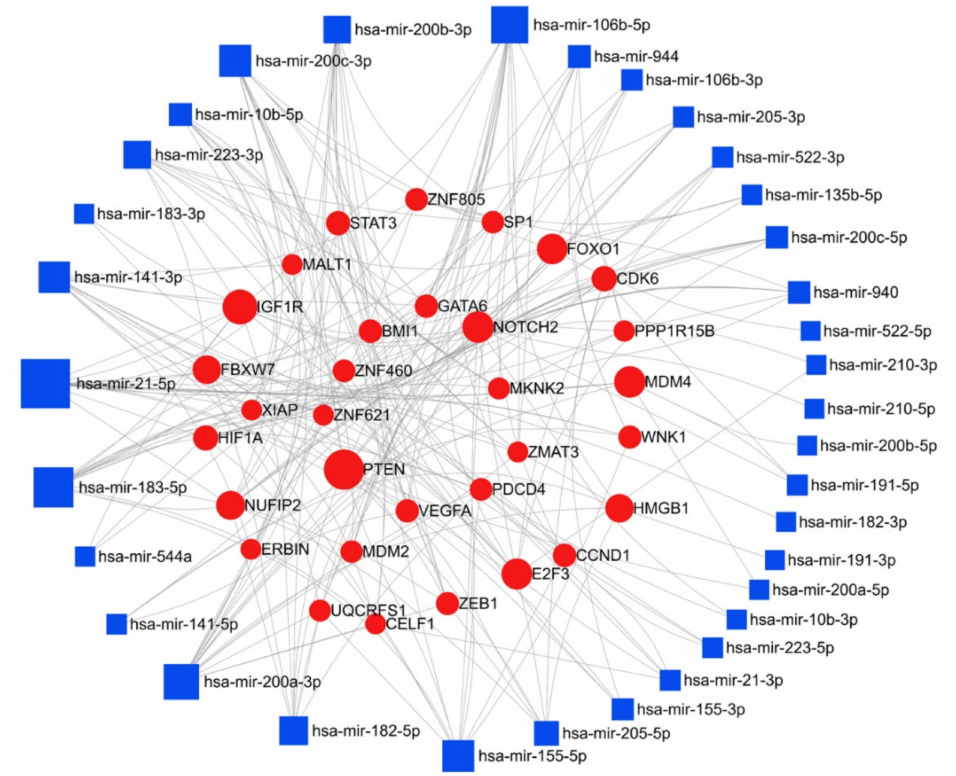
Figure 6. Network of upregulated miR in endometrial cancer: miR deregulated in endometrial cancer were searched in the PubMed database using IRIDESCENT. The network of upregulated miR generated using miRNET (degree filter 5) is shown. The blue squares represent miR, and the red dots represent target genes of these